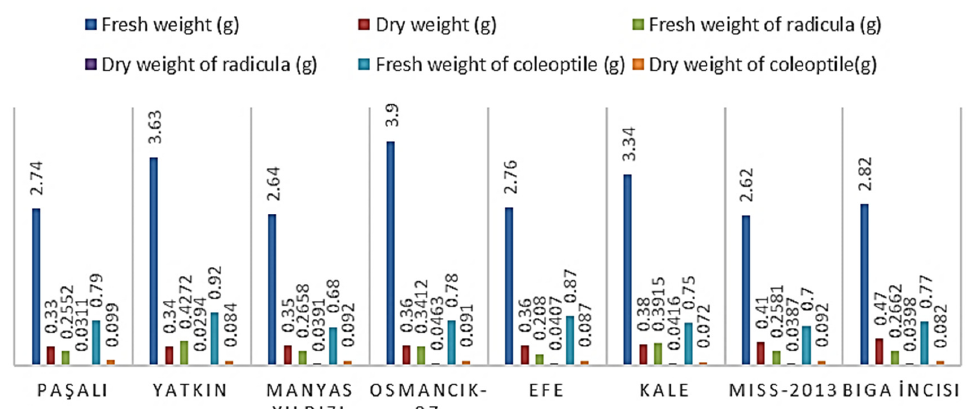
Figure 2. Different NaCl levels effect on fresh weight (g), dry weight(g), dry weight of coleoptile (g), fresh weight of radicula (g) Fresh and dry weight